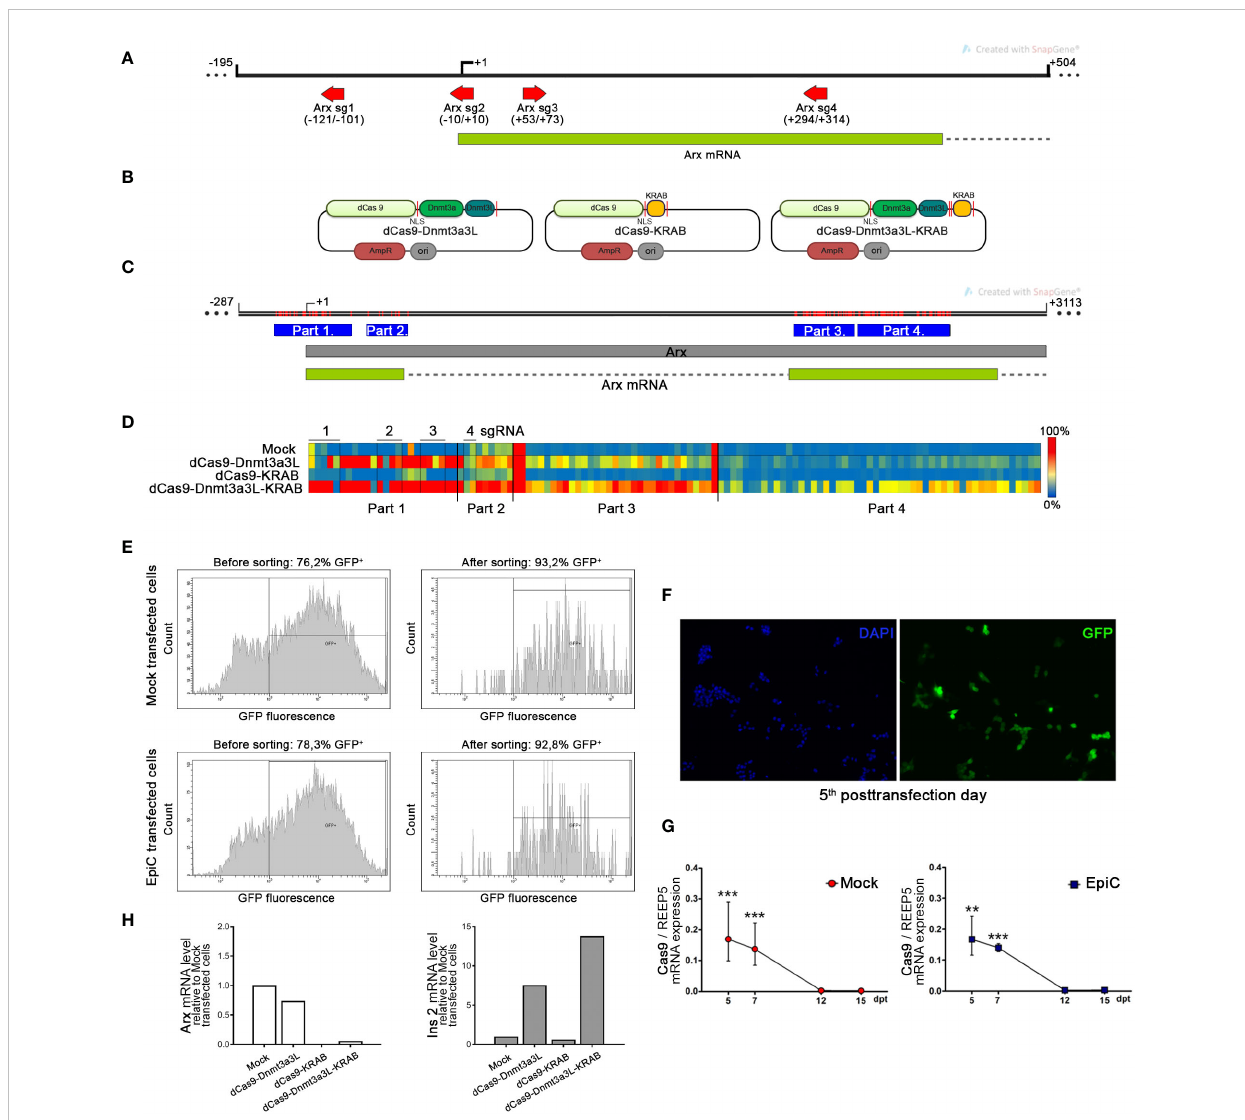
FIGURE 4 Targeted methylation of the Arx promoter in a TC1-6 cells induced by epigenetic editing tool. (A) The map shows the position of the four sgRNAs represented as red arrows which were used for transfection and targeting EpiCRISPR fusion construct. The Arx transcribed region is shown as a green box and the intron as a dashed line. (B) Schematic representation of used fusion constructs for targeted gene repression. The catalytically inactive dCas9 gene was fused to three different domains with a 28 amino acid linker containing NLS peptide. Not drawn to scale. (C) The map shows the part of the X chromosome with the Arx gene indicated as a grey box and with the position of analyzed parts (blue boxes) by bisul fi te sequencing in the Arx gene. Red lines represent CpG sites in the Arx gene. (D) The targeted DNA bisul fi te sequencing analysis represented by the heat map shows the methylation average per CpG site in the Arx promoter sequence. Rows in the heatmap denote separate a TC1-6 co-transfection experiments with one of three different fusion constructs for targeted gene repression in combination with four sgRNAs, while columns represent separate CpG sites in the analyzed region (red-methylated, blue-unmethylated CpG). (E) The fl uorescence-activated cell sorting (FACS) results of transiently transfected a TC1-6 cells before and after cell sorting shows an enrichment of the proportion of fl uorescent cells. (F) Representative fl uorescent microscopy images showed the GFP expression level (green fl uorescence) which corresponds to the high transfection ef fi ciency of a TC1-6 cells on the 5 th post-transfection day. Nuclei were stained with DAPI (blue fl uorescence). (G) The relative Cas9 mRNA expression level in GFP + sorted transfected cell population at 5 th , 7 th , 10 th , 12 th, and 15 th days after transfection (N=3). GFP – green fl uorescent protein; Mock transfected cells – cells transfected with a combination of pmaxGFP ™ Vector , a plasmid for epigenome editing (dCas9-3a3L-KRAB), and empty gRNA vector; EpiC transfected cells - cells transfected with a combination of pmaxGFP ™ Vector , the plasmid for targeted gene repression and four sgRNAs for targeting Arx gene promoter (Arx sgRNA 1-4 vectors). (H) The relative mRNA expression level of Arx and Ins2 on the 5 th post-transfection day was determined by RT-qPCR analysis (N=2). The REEP5 mRNA level expression was used as an endogenous control. The results are expressed as means ± SDs. The Kolmogorov-Smirnov test (with D-W-L P value) was used for determining the normality of the samples. The one sample t-test was used for determining statistical signi fi cance values with normal distribution. For data with non-normal distribution, the Wilcoxon Signed Rank test was applied, **p ≤ 0.01, ***p ≤